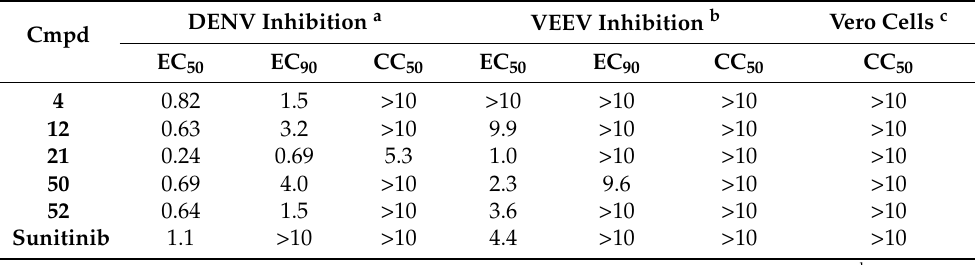
Table 5. Extension screening on VEEV and on Vero cells for lead compounds 4 , 12 , 21 , 50 and 52